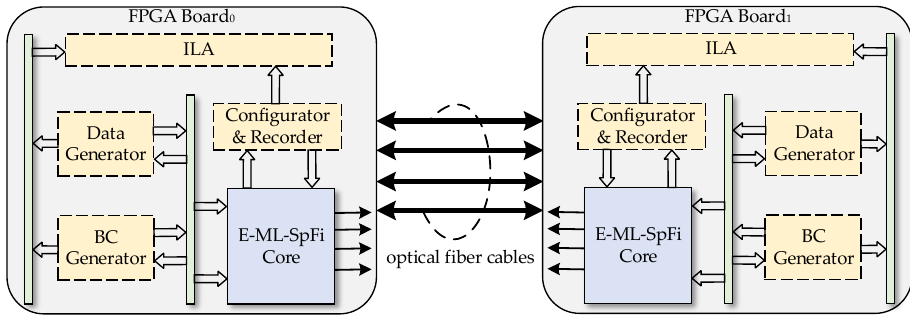
Figure 8. A schematic representation of board-level verification platform s .